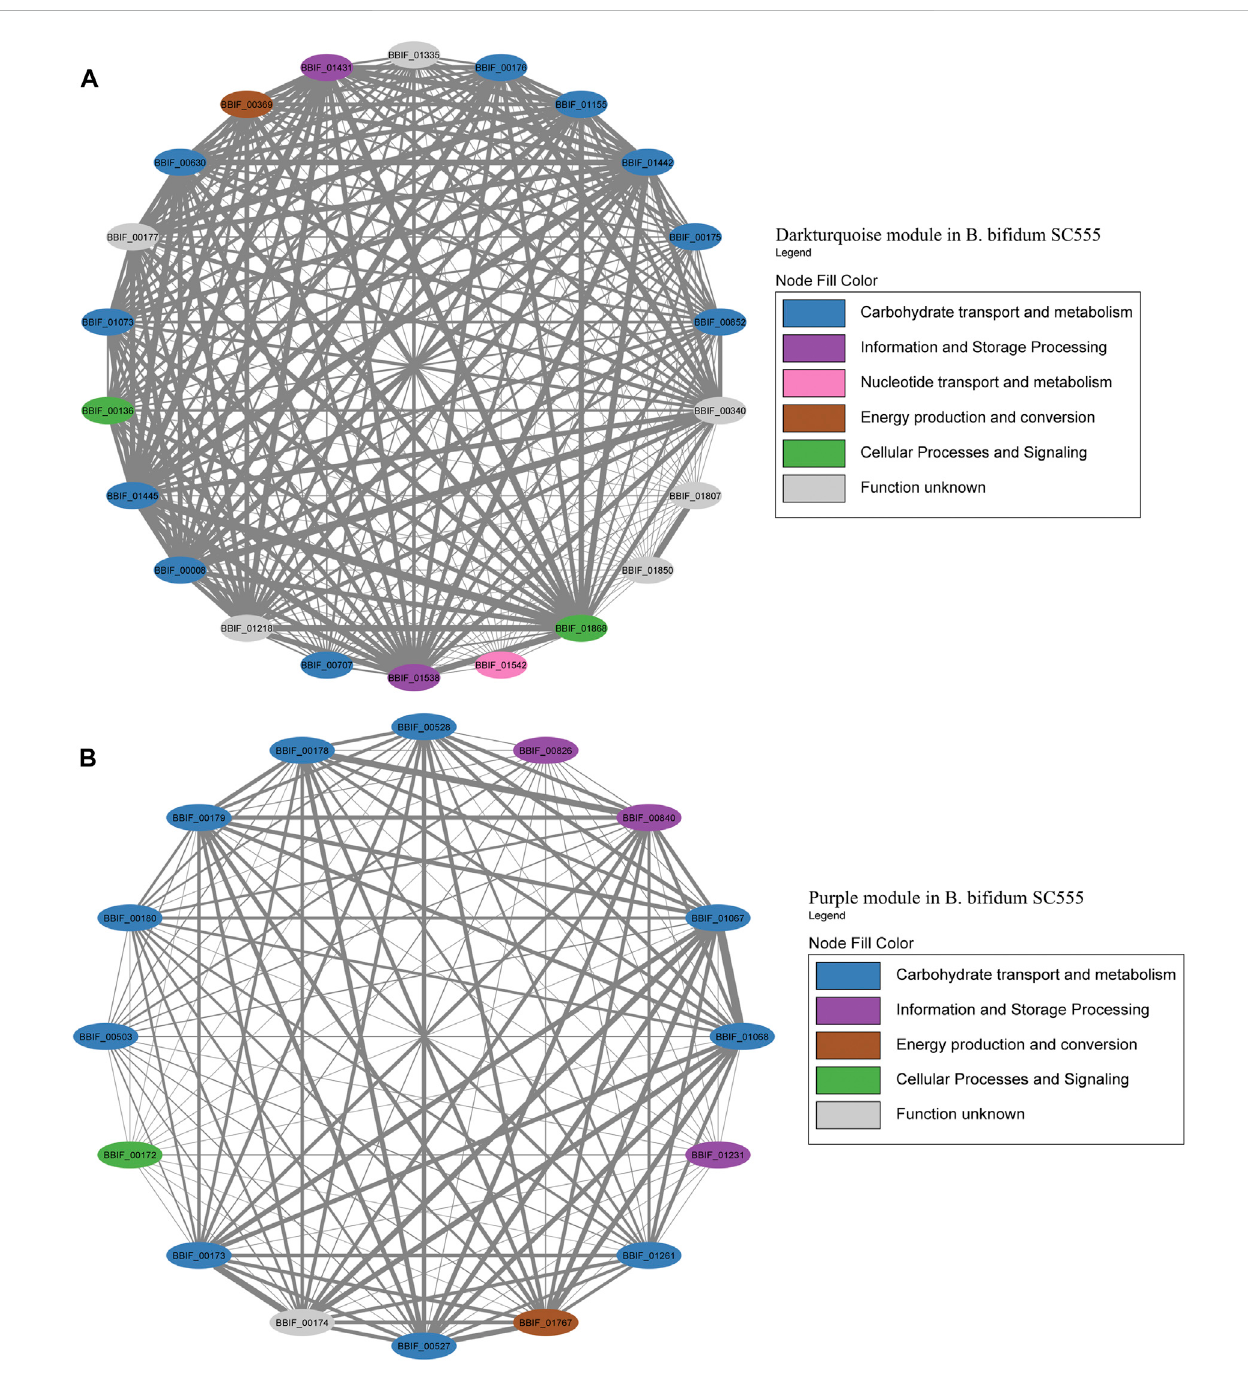
FIGURE 9 HMO-related co-expression networks in B. longum . (A) Green and (B) Darkgreen modules for B. longum SC596. All Network construction consisted of modulesweremanuallyanalyzed,andthosecontainingHMO-metabolizinggeneswereusedtocreateaco-expression network.Thisanalysisconsideredthe neighboring genes of each node with the highest